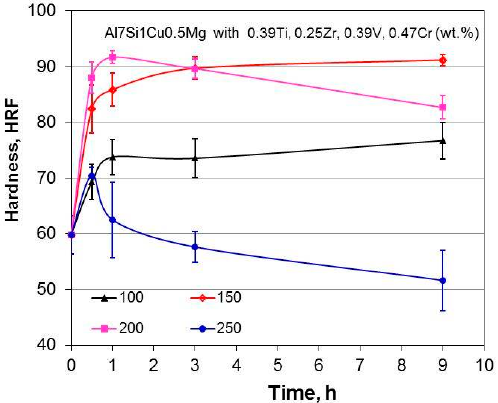
Figure 23. Hardness changes during aging of the Al7Si1Cu0.5Mg alloy modified with 0.39 wt.% Ti, 0.25 wt.% Zr, 0.39 wt.% V, and 0.47 wt.% Cr. Solution treatment included heating at 510 °C for 0.5 h followed by 4.5 h at 525 °C and water quench [109].